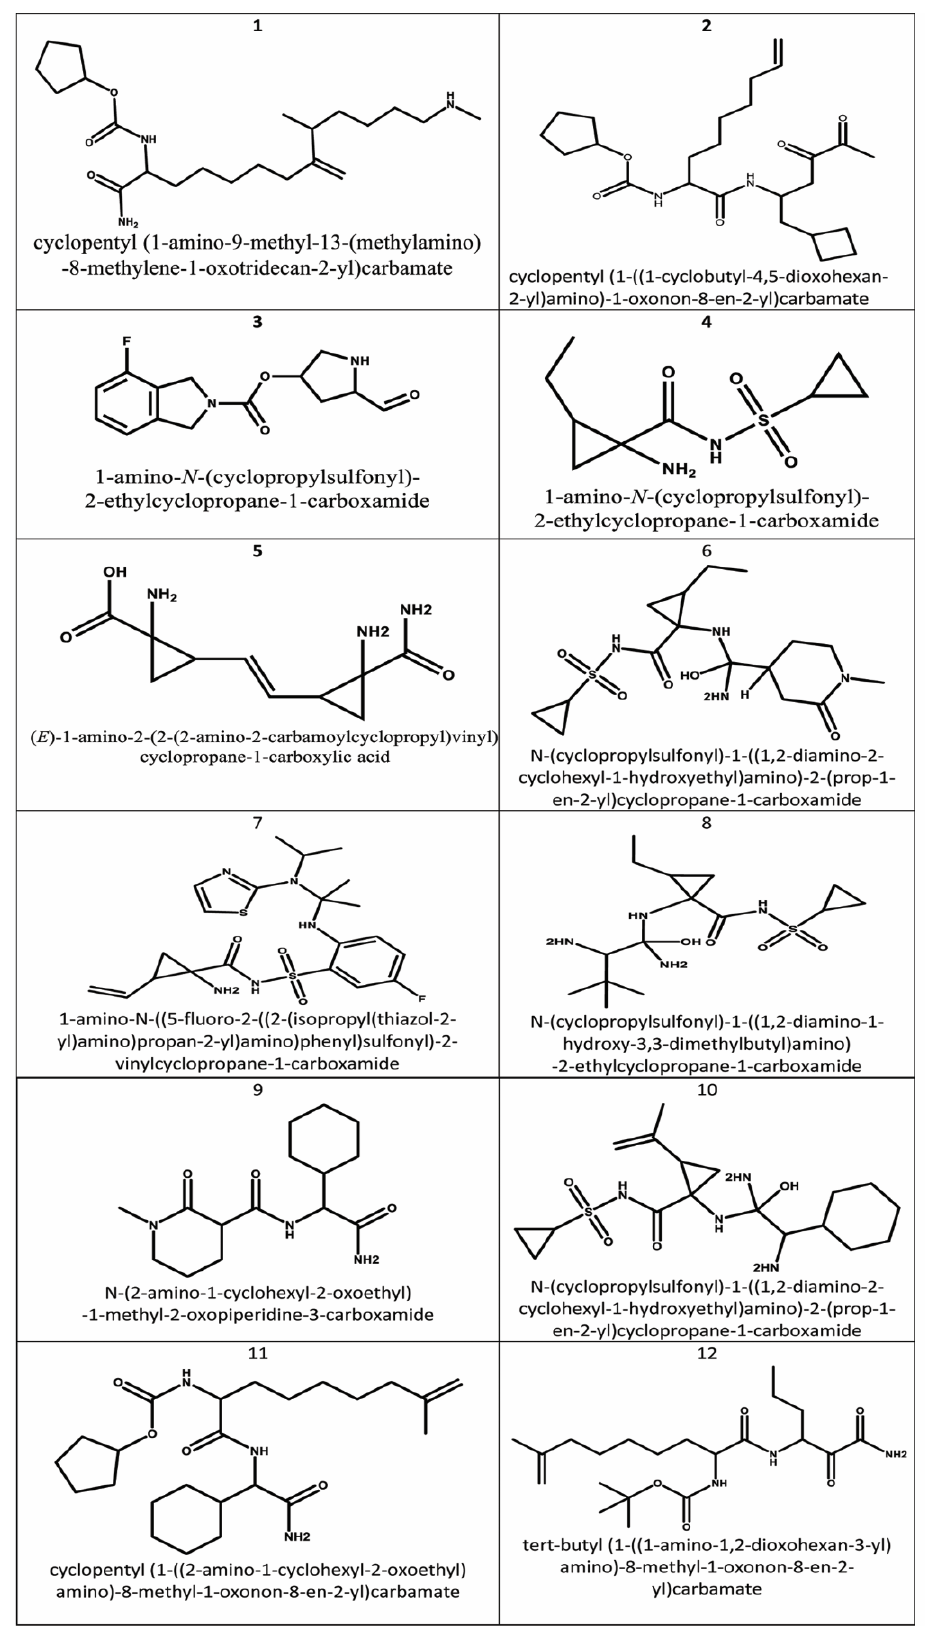
Figure 5. 2D chemical structures of the newly modeled inhibitors of HCV NS3/4A protease.